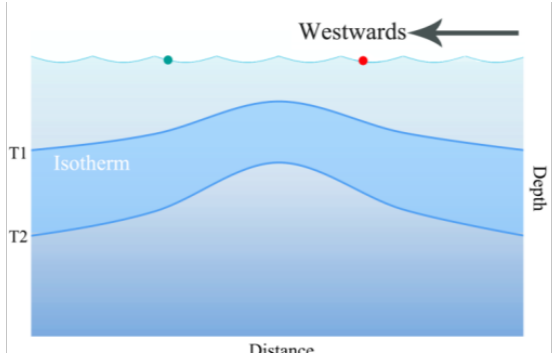
Figure 11. Distribution of isotherms in cyclonic eddies. Two isotherms are depicted showing the structure of interior temperature. The red and green dots denote the observed locations of Argo profiles in the case of Soudelor and Halola, respectively.